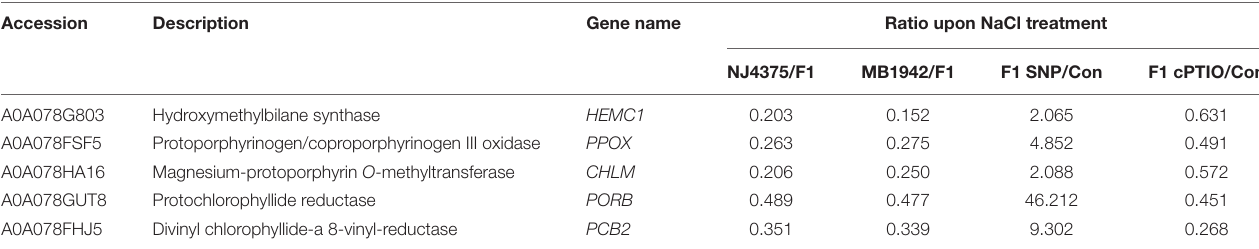
TABLE 2 | List of chlorophyll metabolism proteins in the seedling leaves of B. napus materials in response to salt stress for 3 days with or without sodium nitroprusside (SNP) or 2-(4-carboxyphenyl)-4,4,5,5-tetramethylimidazoline-1-oxyl-3-oxide potassium salt (cPTIO) pre-treatment for 12 h. Accession